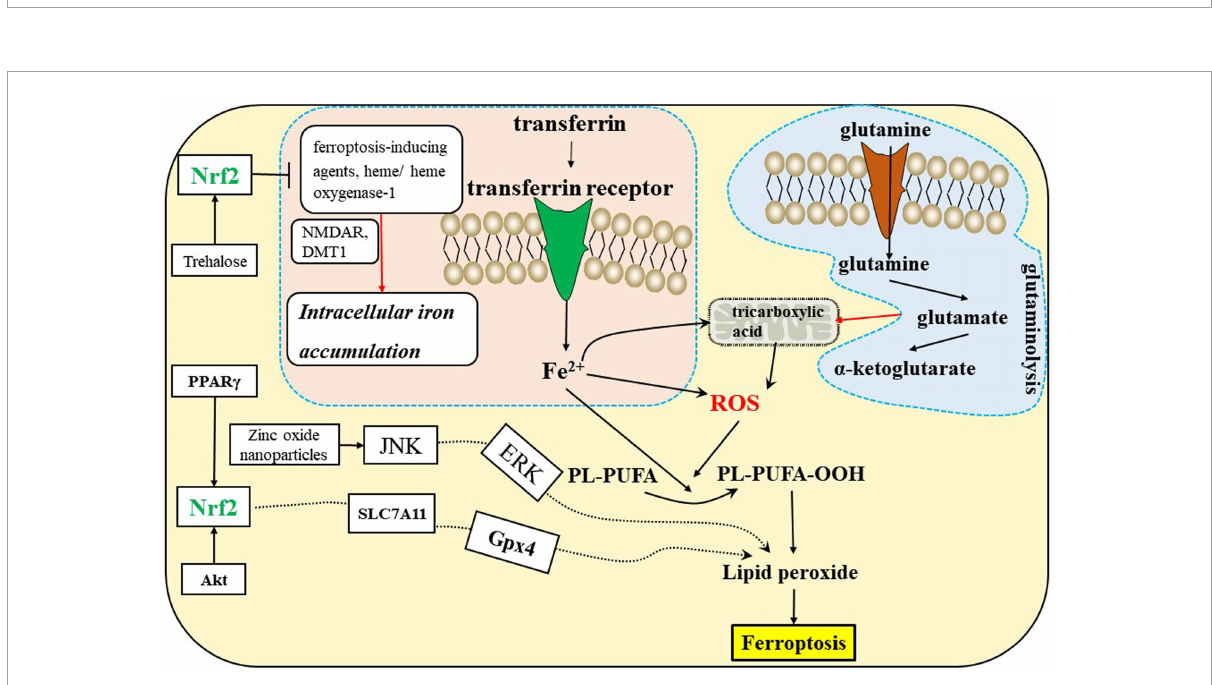
FIGURE3 Ferroptosis is related to the iron, amino acid metabolism, and Nrf2 signaling pathways in the CNS. DMT1, divalent metal transporter 1; NMDAR, N -methyl- D -aspartate receptors; Nrf2, nuclear factor erythroid 2-related factor 2; PPAR γ , peroxisome proliferator-activated receptor γ .